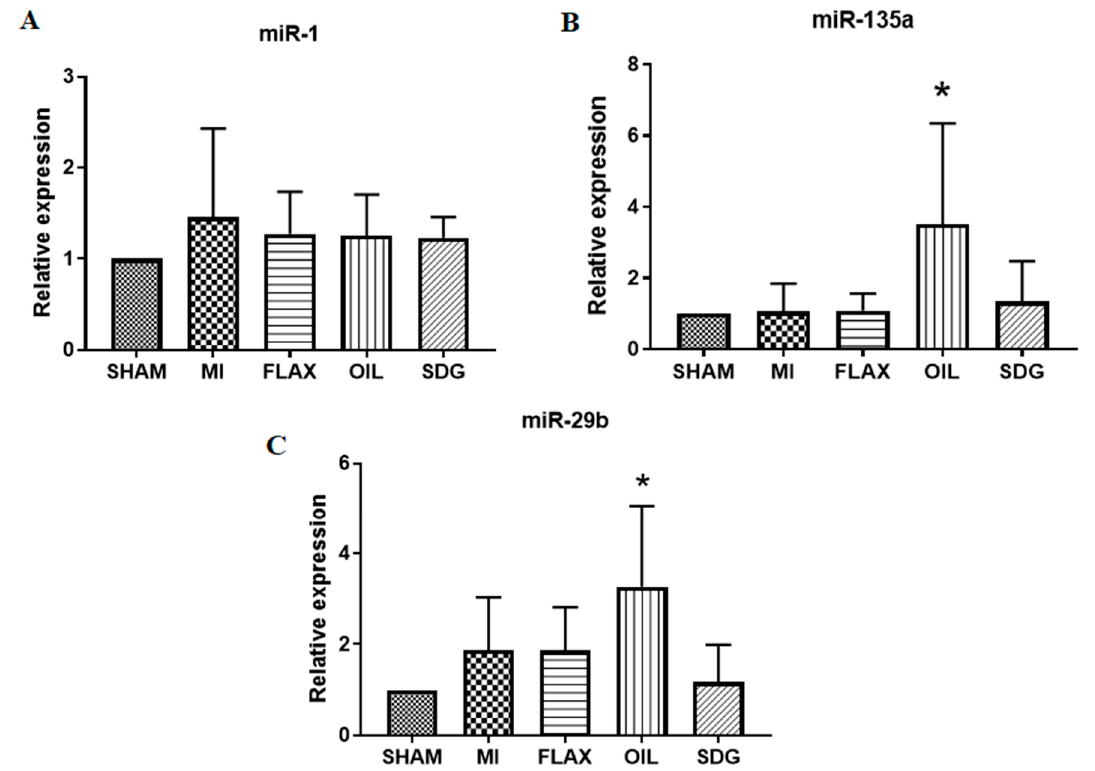
Figure 4. Effect of dietary interventions on: ( A ) miR-1; ( B ) miR-135a; ( C ) miR-29b, expression levels. Data are presented as mean ± SD, n = 5–6. * Significantly different from sham, p < 0.05. ALA, alpha- linolenic acid; FLAX, chow diet supplemented with 10% ground flaxseed; MI, myocardial infarction; OIL, chow diet supplemented with 4.4% ALA enriched flax oil; SDG, chow diet supplemented with 0.44% secoisolariciresinol diglucoside.